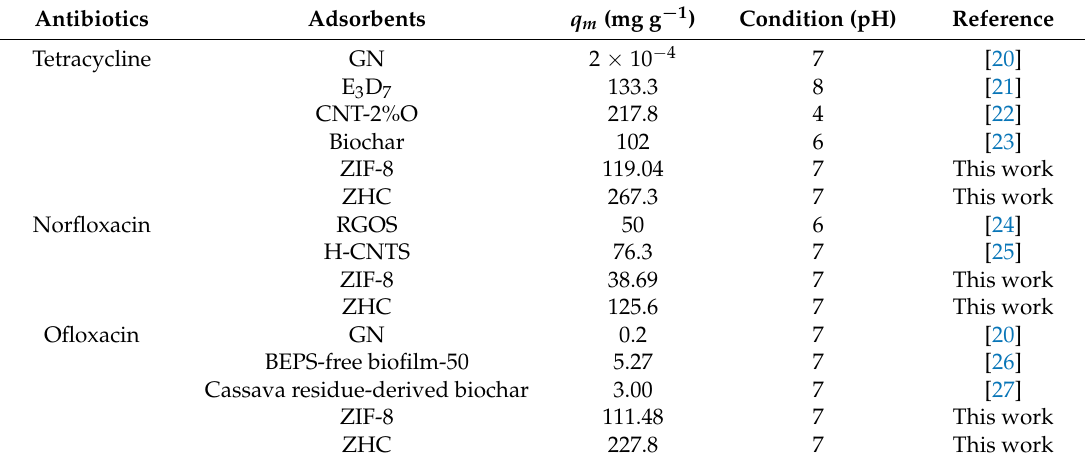
Table 2. Comparison of the TC, NFO, and OFO adsorption ability of ZHC with other inorganic